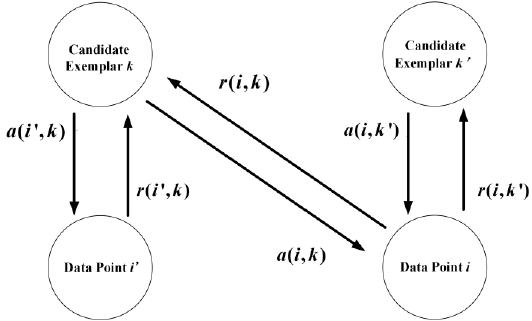
Figure 1. Two messages, responsibility ( r ( i , k ) , r ( i (cid:48) , k ) , and r ( i , k (cid:48) ) ), and availability ( a ( i , k ) , a ( i (cid:48) , k ) , and a ( i , k (cid:48) ) ), are passing in an affinity propagation network. The responsibility r ( i , k ) and r ( i (cid:48) , k ) reflect how well the point k acts as an exemplar to the point i and i (cid:48) , respectively. The availability a ( i , k ) and a ( i (cid:48) , k ) reflect how well the point i and i (cid:48) belong to a class centered on point k . The responsibility r ( i , k (cid:48) ) reflects how well the point k (cid:48) acts as an exemplar to the point i (cid:48) . The availability a ( i , k (cid:48) ) reflects how well the point i belongs to a class centered on point k (cid:48)